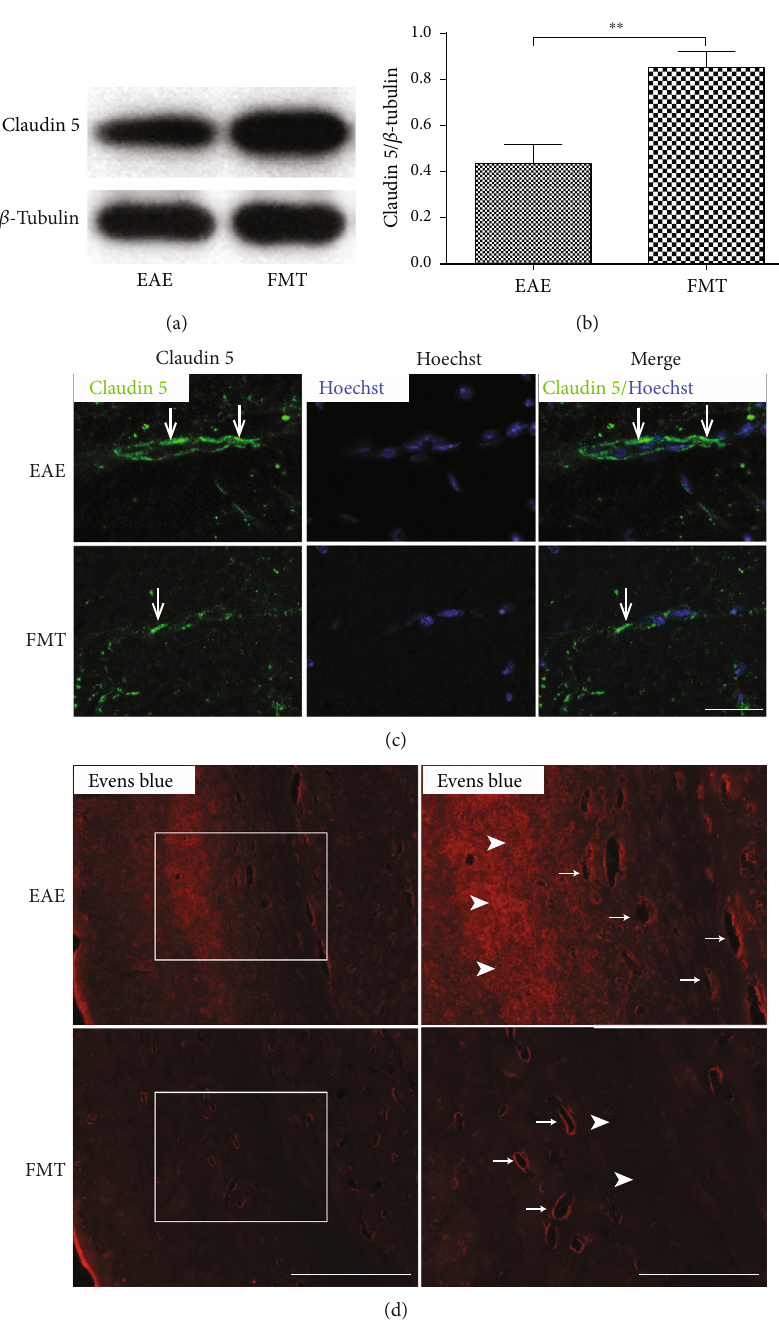
Figure 3: FMT prevents BBB leakage in EAE. (a) Claudin 5 expression in thoracic spinal cord tissues collected from EAE controls and FMT- treated EAE mice revealed by Western blot with β -tubulin as loading control. (b) Chart of quanti fi ed Western blot results showing increased levels of Claudin 5 expression (normalized by β -tubulin) after FMT treatment ( mean ± SEM ; n = 6 /group; ∗∗ p < 0 : 01 ). (c) Representative immunostaining images of Claudin 5 expression (green) in spinal cord sections. The nucleus was stained with Hoechst (blue). Scale bar: 100 μ m. (d) Representative images of Evans blue dye extravasation (red) in the subcortical white matter of brain showing the presence of dye in both blood vessels and brain parenchyma in EAE controls (upper panels) in contrast to appreciably reduced dye presence in brain parenchyma in FMT-treated EAE mice (lower panels). Each right panel shows a high magni fi cation image of the area inside the white box (left). Scale bars: 400 μ m (left) and 200 μ m (right). Representative brain parenchyma and blood vessels are indicated by arrowheads and arrows,